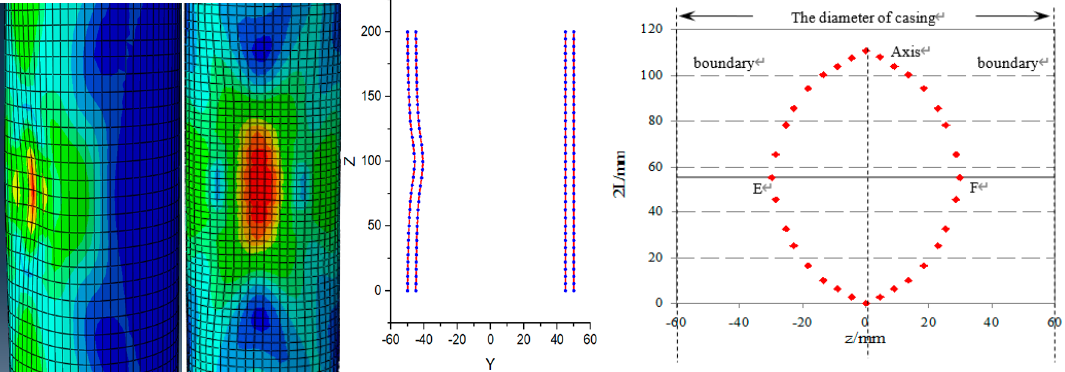
Figure 2. Simulation of casing deformation by the finite element method.